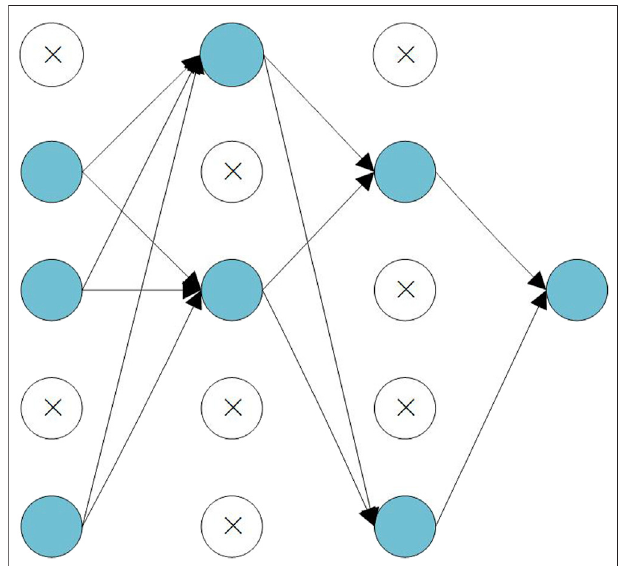
FIGURE 5 | Dropout strategy